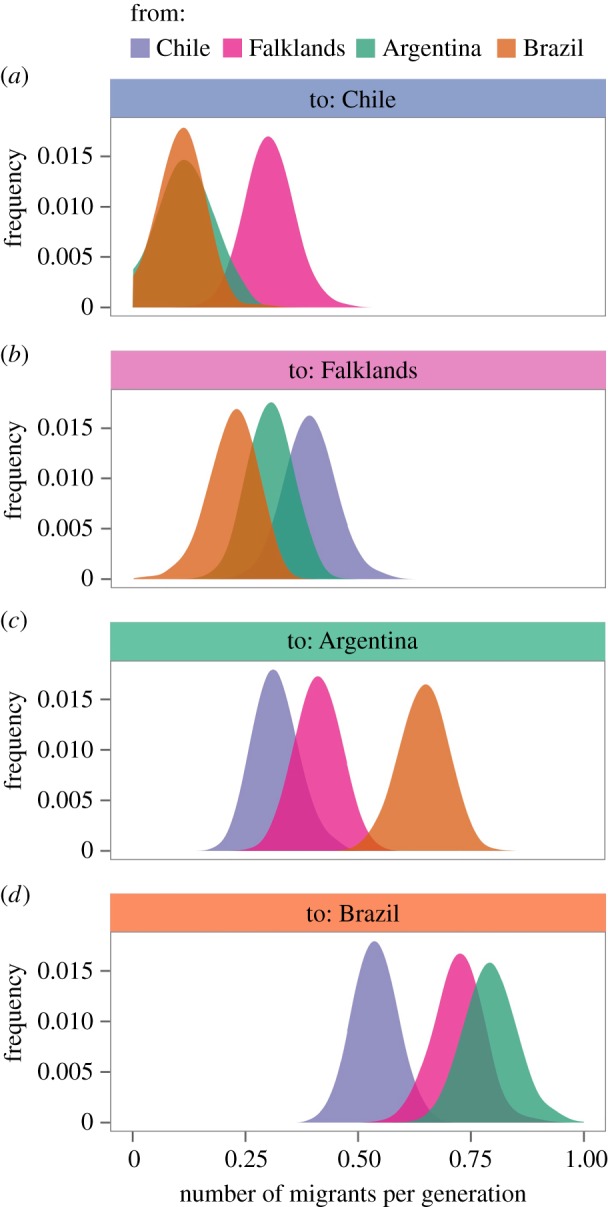
Migration rate estimates calculated from the mitochondrial control region using Migrate [71,72]. Depicted are distributions of migration rate estimates from Chile (blue), the Falklands (pink), Argentina (green) and Brazil (orange) towards (a) Chile; (b) the Falklands; (c) Argentina and (d) Brazil.